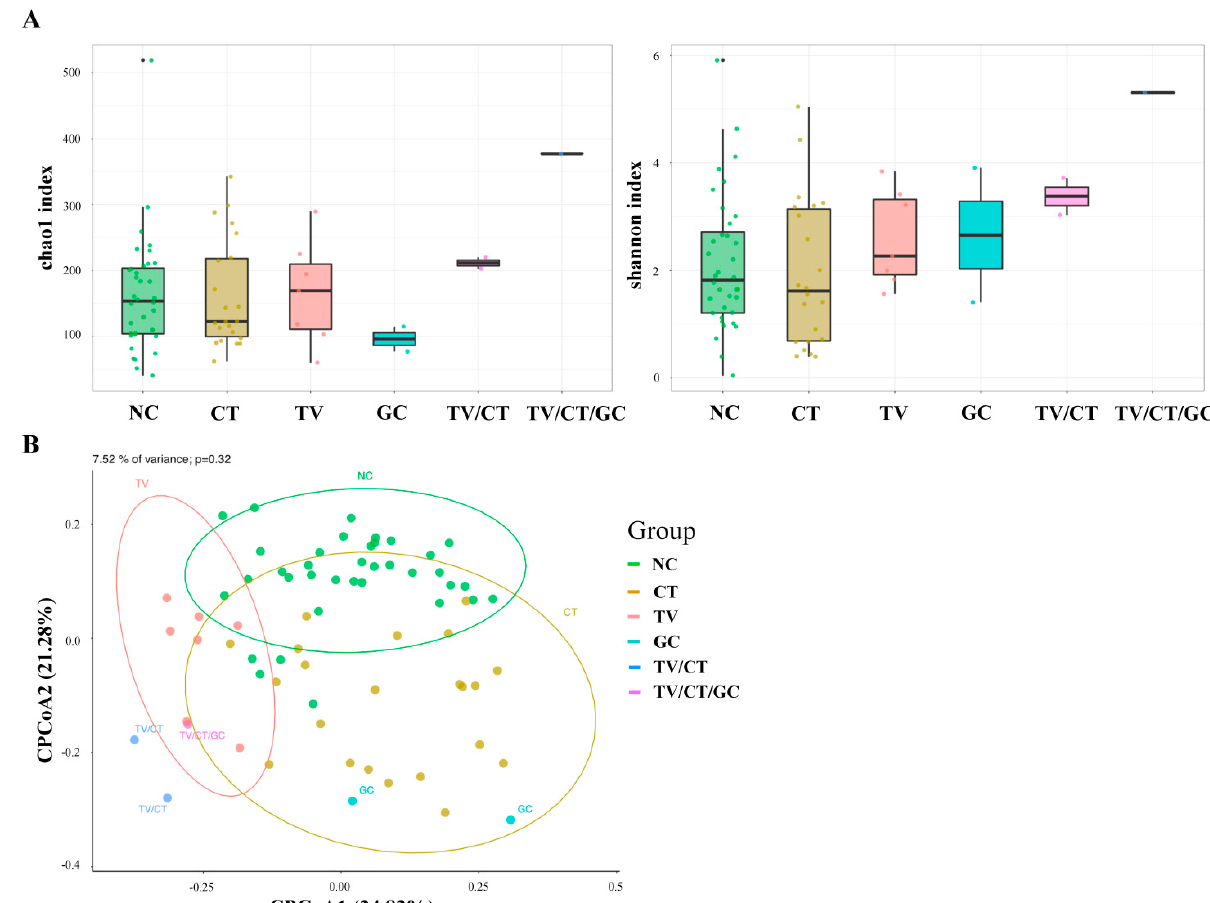
Figure 2. Microbial community variations between STI-positive and non-STI (NC) groups. ( A ) Bacterial α -diversity was determined by Chao and Shannon’s indices in STI-positive and NC groups. ( B ) Principal component analysis (PCoA) in STI-positive and NC groups. The individual samples were color-coded in the NC group and STI-positive patients, including CT, TV, GC, TV/CT, and TV/CT/GC.